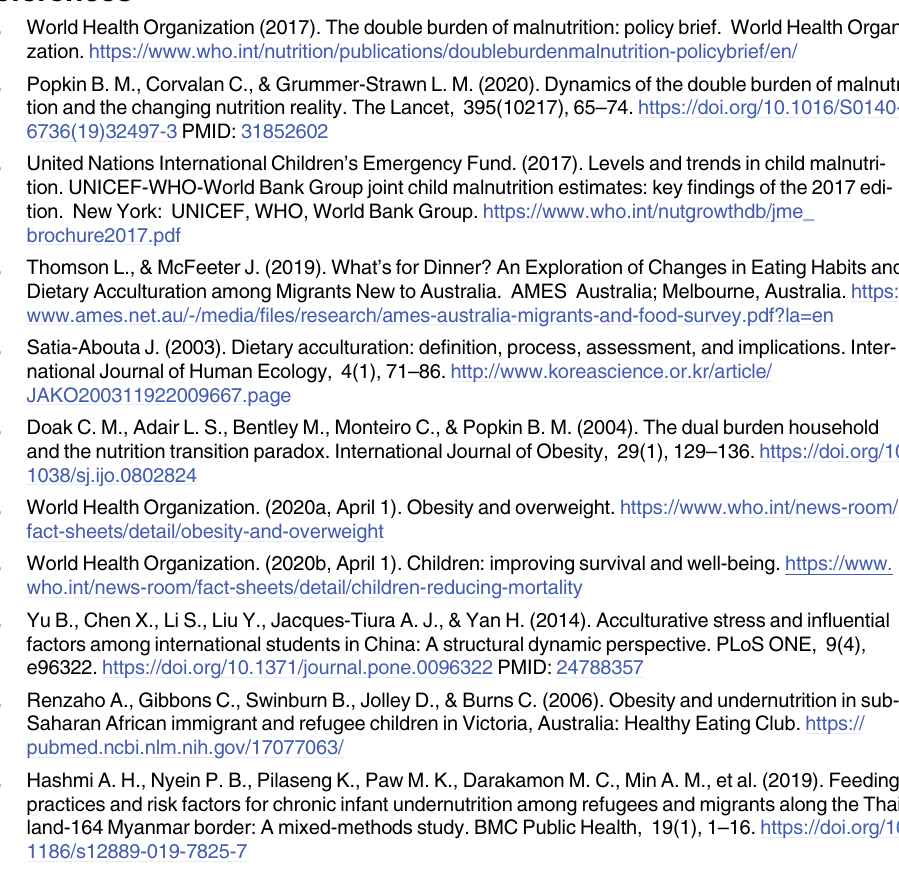
S1 Table. Quality assessment of included studies. S2 Table. PRISMA 2020